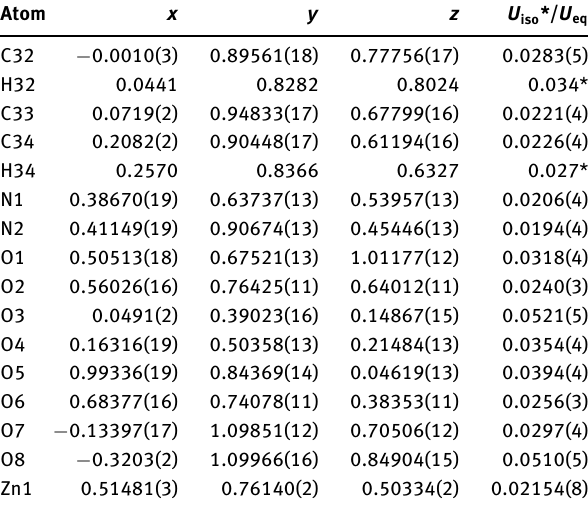
Table 2: Fractional atomic coordinates and isotropic or equivalent isotropic displacement parameters (Å 2